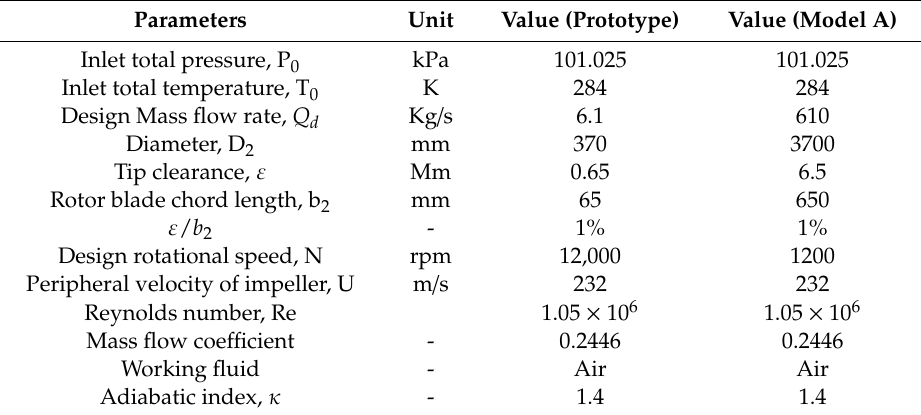
Table 2. Design parameters of prototype and compressor